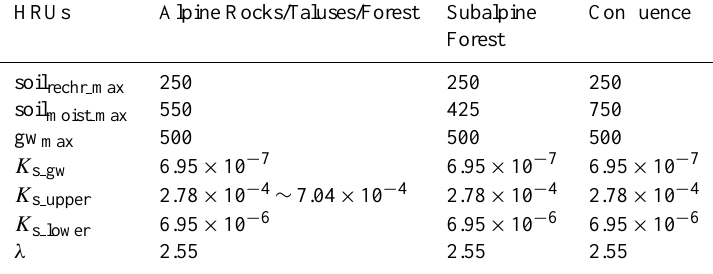
Table 2. Parameters for the hillslope module. soil rechr max [mm], soil moist max [mm], and gw max [mm] are the water storage capacity for the recharge, soil of both recharge and lower, and groundwater layers, respectively. K s gw [ms − 1 ], K s upper [ms − 1 ] and K s lower [ms − 1 ] are the saturated hydraulic conductivity in the groundwater, recharge, and lower of soil layers, respectively. λ [ − ] is the pore size distribution